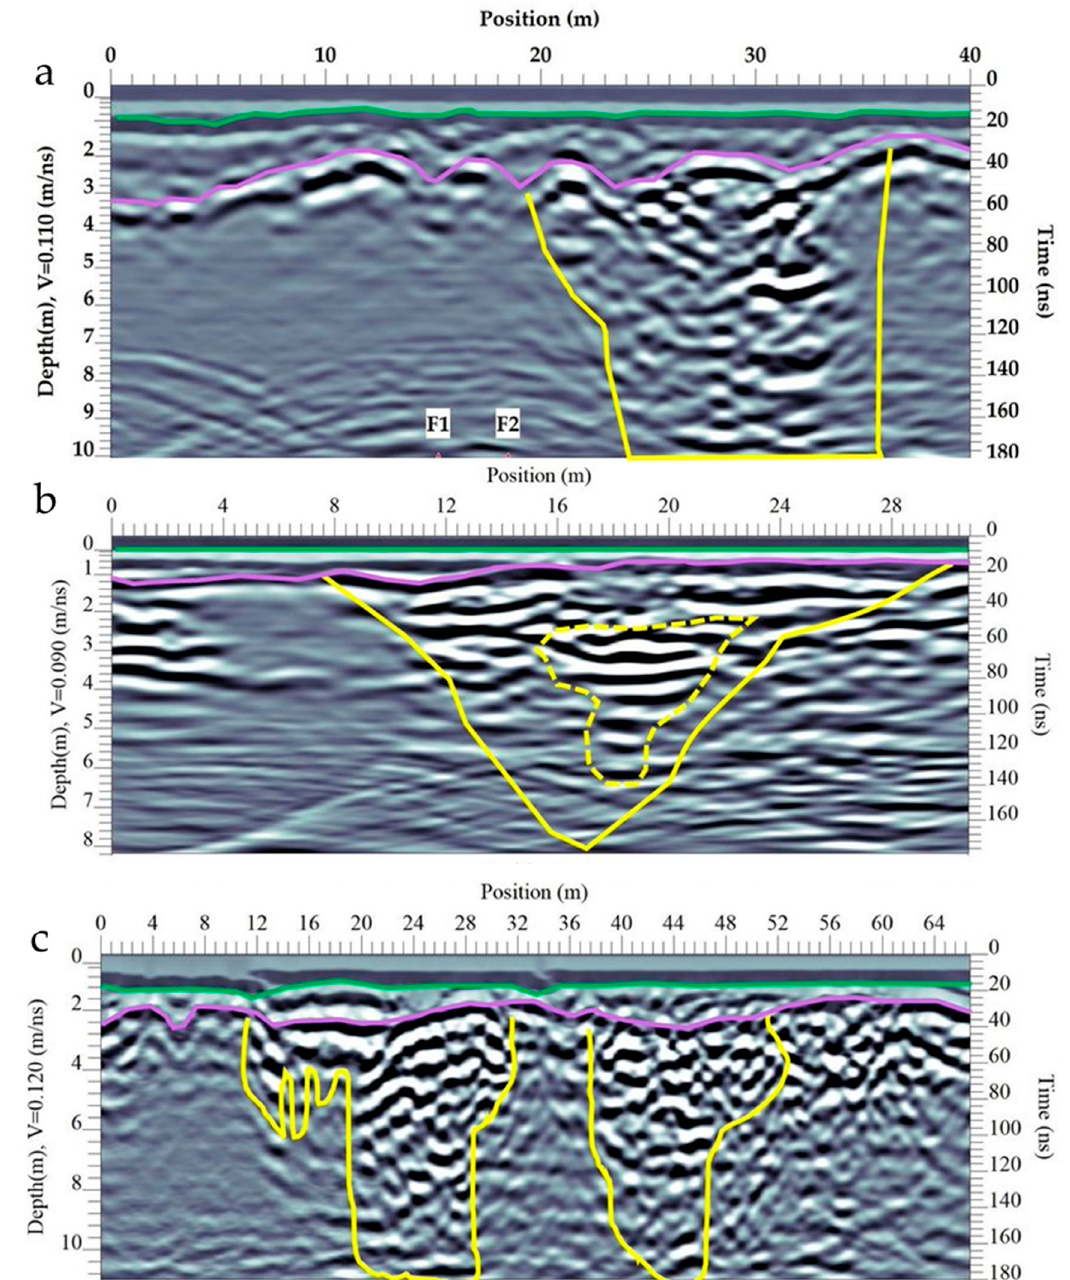
Figure 4. ( a ) GPR survey near the southwestern portion of the draw; green indicates the interpreted top of the soil surface, and purple indicates the interpreted top of epikarst surface. The yellow outline annotates what is interpreted as a sinkhole funnel that is yet to collapse; ( b ) GPR survey in the middle portion of the draw. The yellow dashed line indicates the boundaries of a possible cavity; ( c ) GPR survey along a road adjacent to the west bank of Ichawaynochaway Creek; the yellow outlines annotate interpreted the continuation of solution-enlarged fissures that are visible in outcropping from the stream. These fissures align with the documented fracture pattern in the region [6,7,25,26].